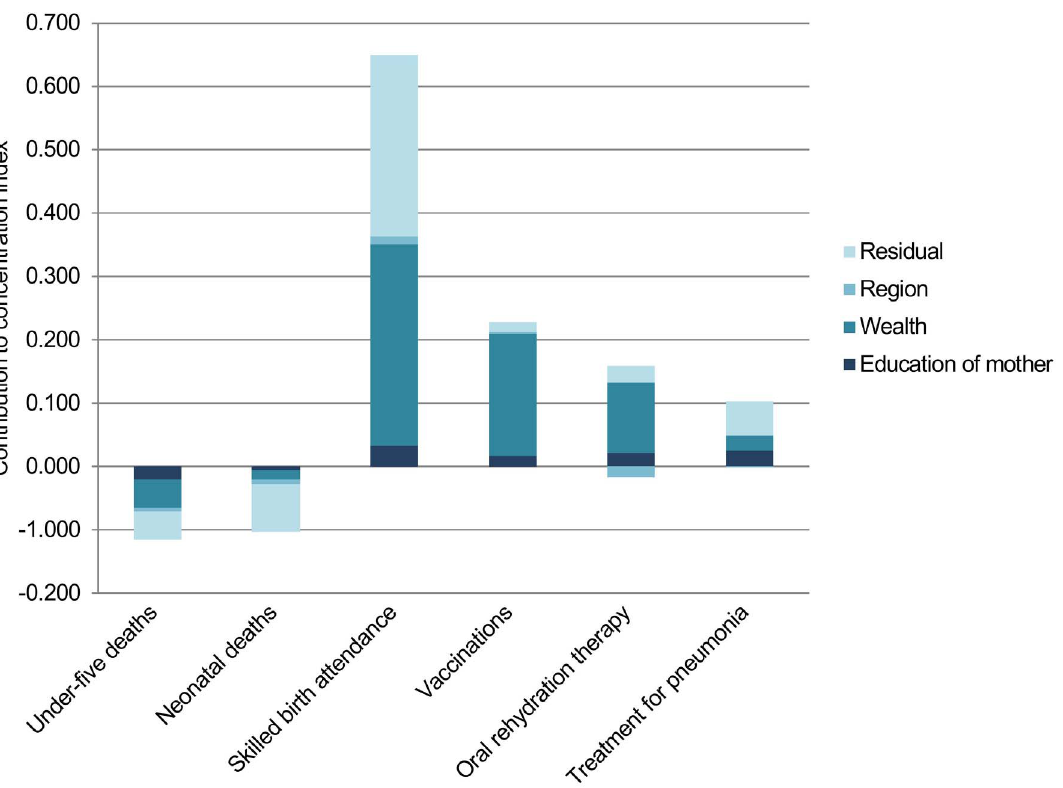
Figure 2. Factors contributing to socioeconomic inequality. Contribution of wealth, the mother’s education and region of residence to the total socioeconomic inequality, as measured by the concentration index, for each of the indicators in 2011.